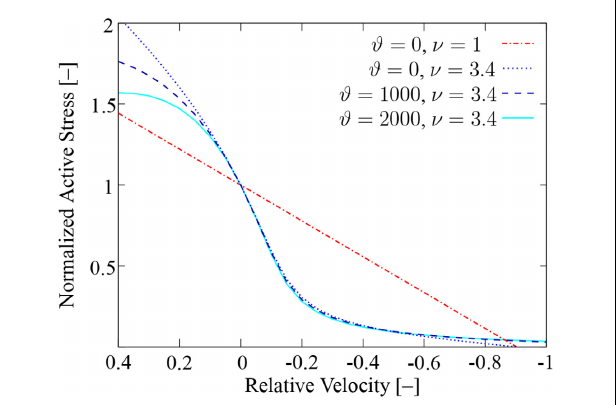
FIGURE 4 | F - v relation of an isolated half-sarcomere model. Shown is the relation for constant rate coefficients (red dash-dotted line), for variability in f 0 only (blue dotted line), and for additional variability in g 0 (blue dashed line and turquoise solid line). To depict the Hill relation in its typical form, the x-axis is inverted to show shortening contractions on the